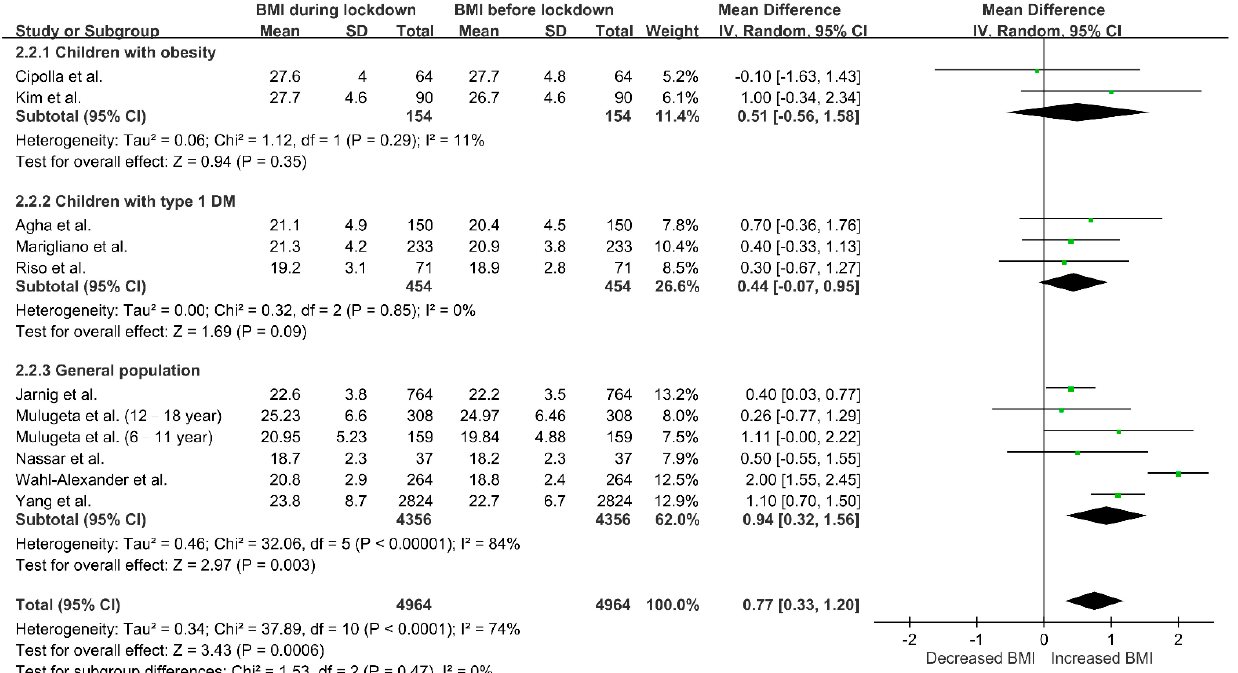
Figure 3. Changes in BMI during lockdown in children. Study populations were further divided into three groups (chil- dren with obesity, children with type 1 diabetes mellitus and children without comorbidities), and subgroup analysis was performed. Abbreviations: BMI, body mass index; DM, diabetes mellitus.